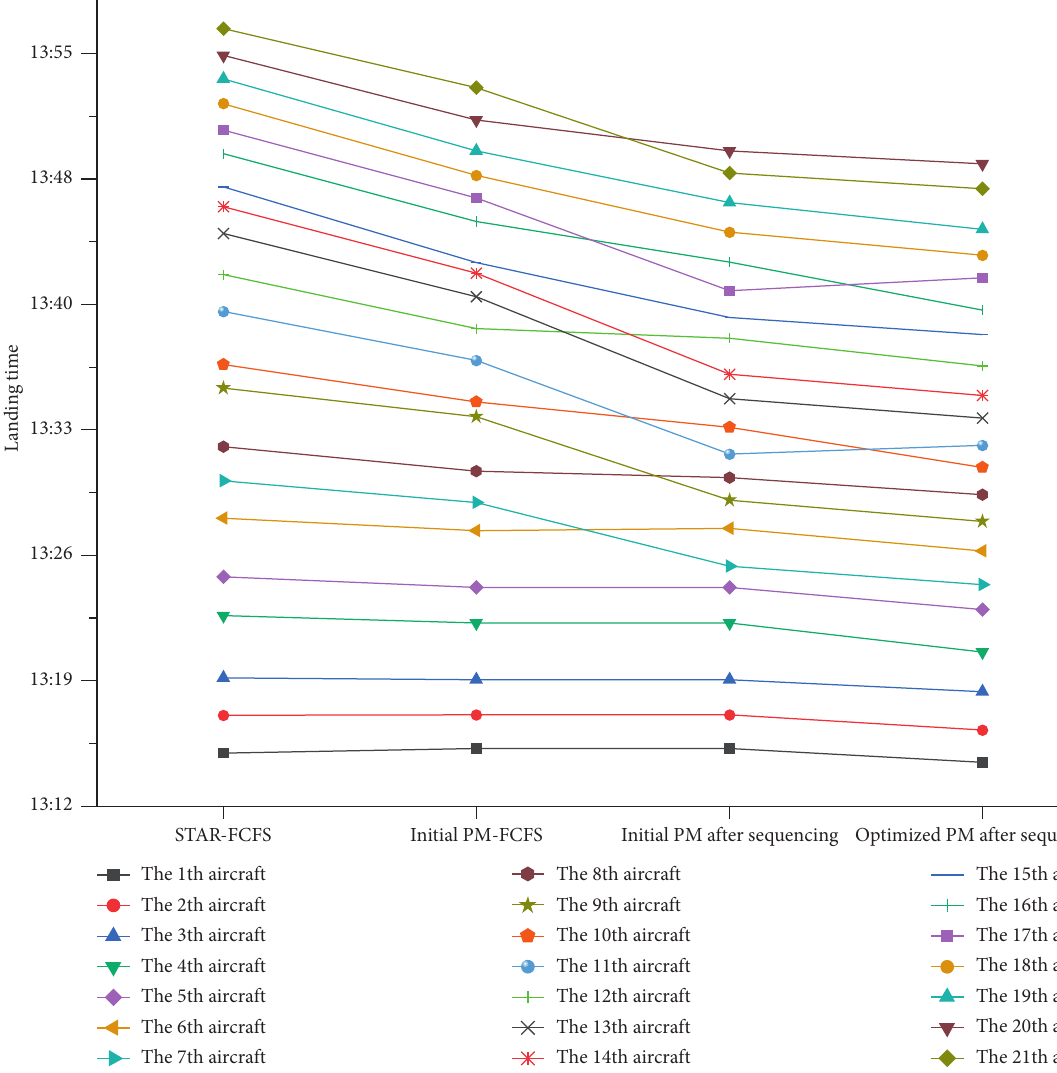
Figure 19: Actual landing time of aircraft under different